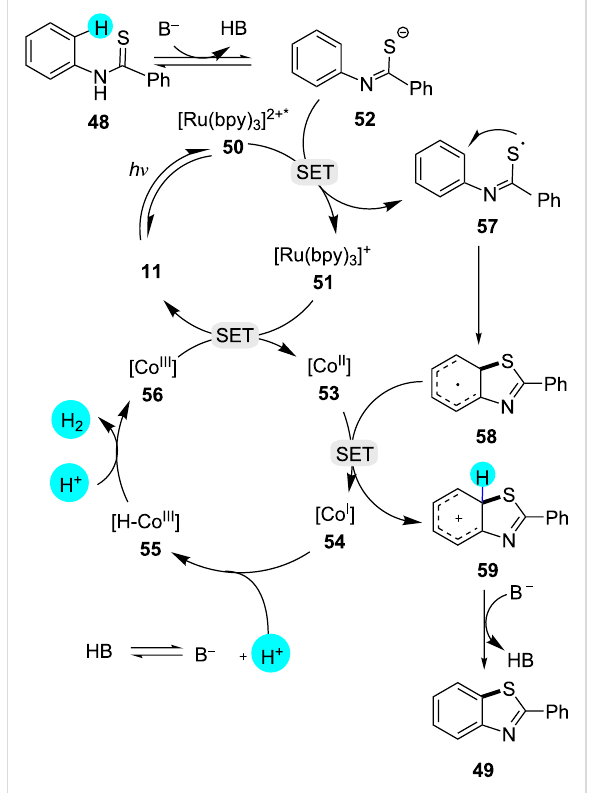
Figure 10: Mechanism involved in the synthesis of benzothiazoles via oxidant-free C–H thiolation.